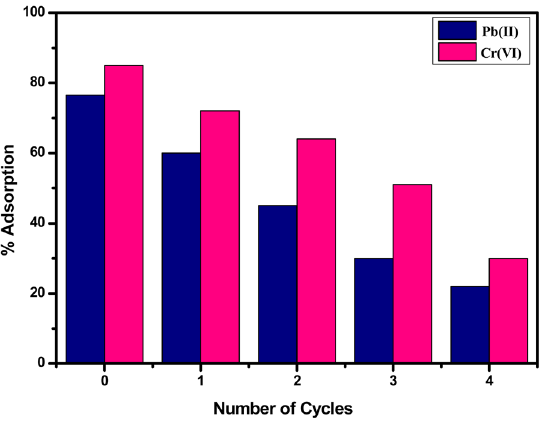
Figure 17. Adsorption capacity of Pb(II) and Cr(VI) ions on regeneration of acid functionalized